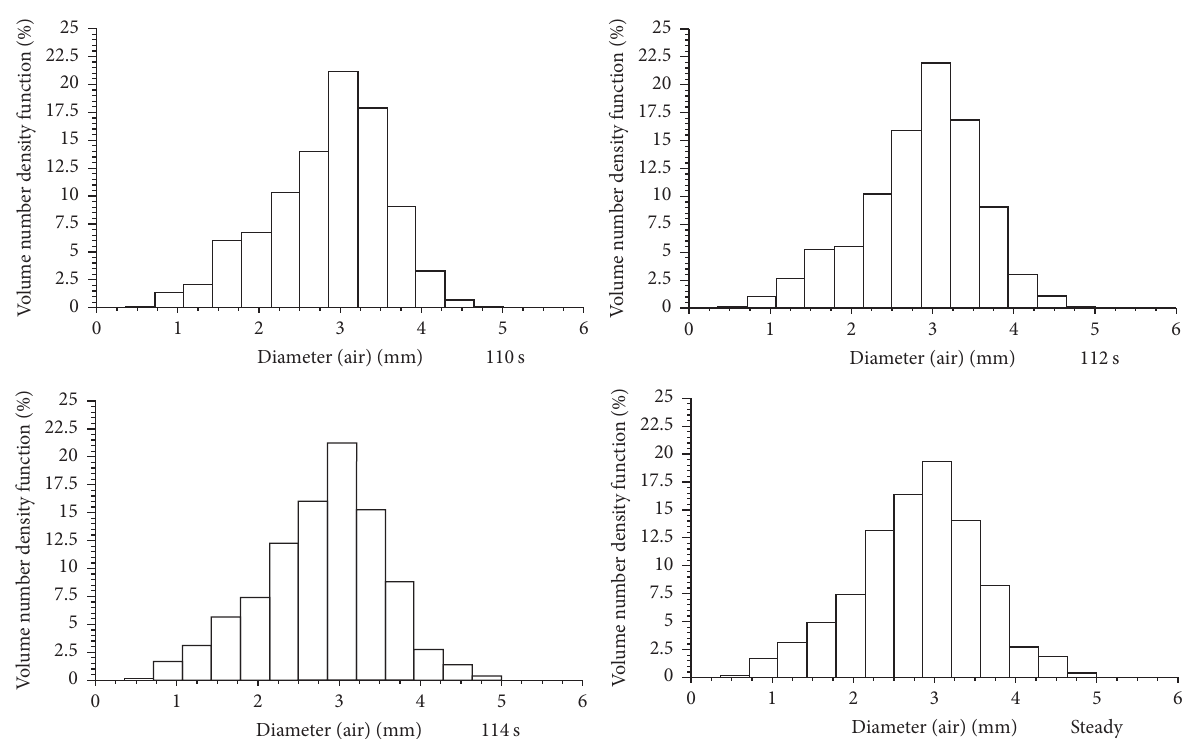
Figure 9: The overall SMD histogram in the gas-liquid STR 𝑄 𝑔 = 0.065 vvm, 250